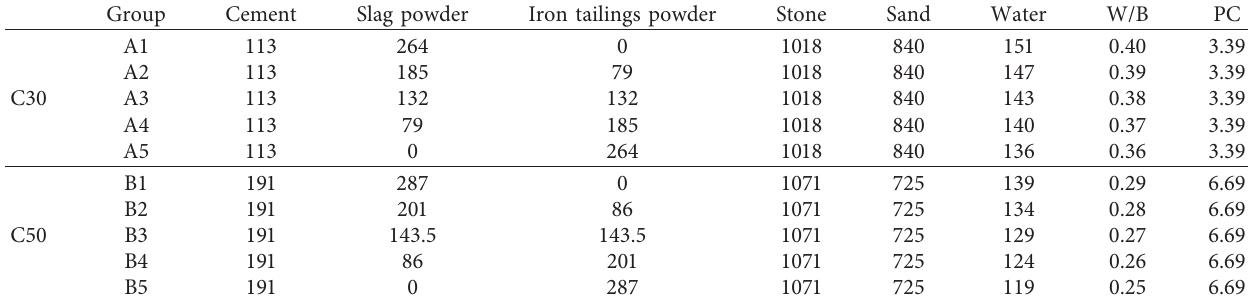
Table 3: Concrete mix proportion (kg · m − 3 ).